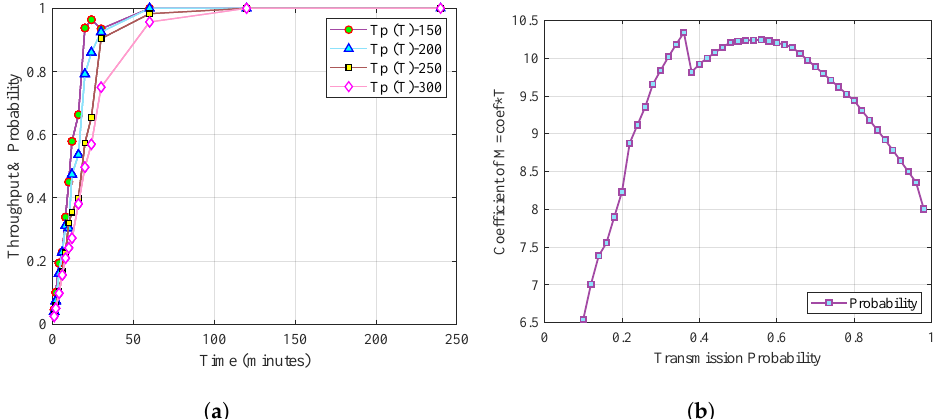
Figure 4. Cognitive channel transmission opportunity. ( a ) Throughput and probability vs. time; ( b ) transmission probability.